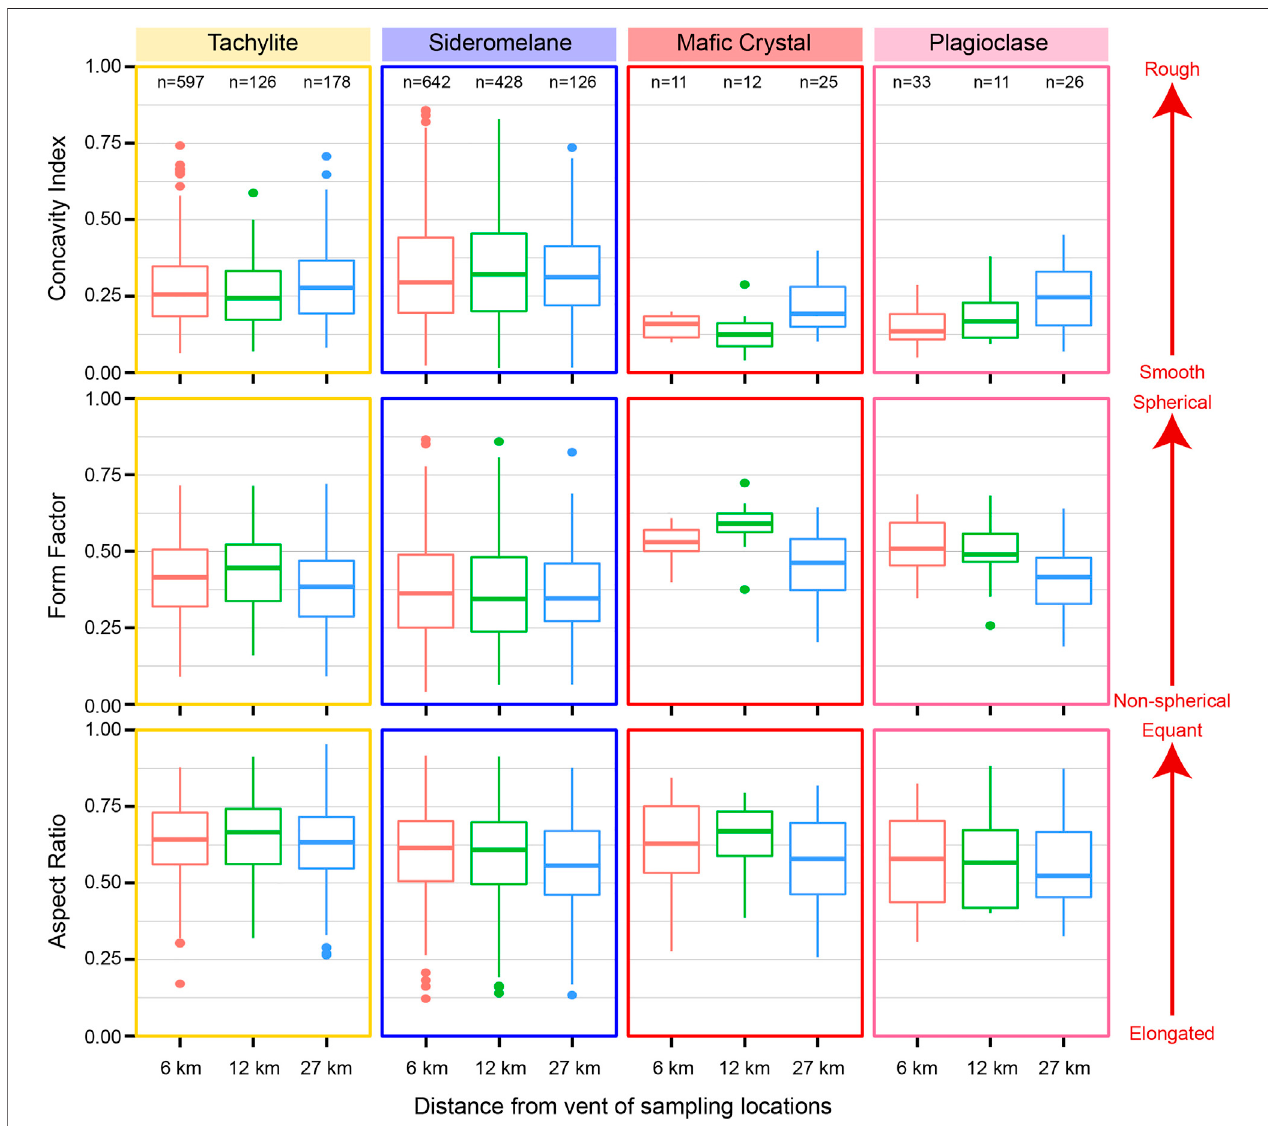
FIGURE 8 | Variations with distance from vent of the Concavity Index, Form Factor and Aspect for the different textural componentry groups in the 125 – 180 µm size fraction, represented by Tukey whiskers plots (see caption of Figure 5 for a description of these boxplots).